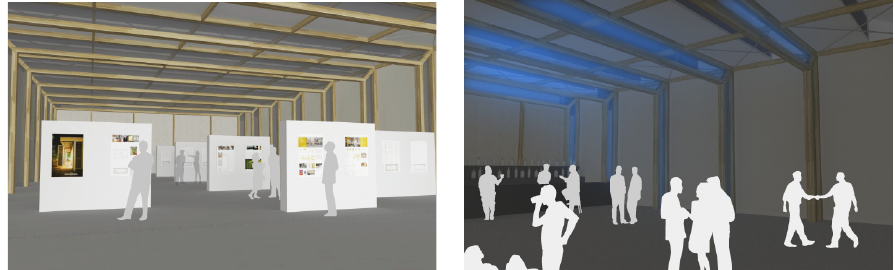
Figure 13a and b: Use of the composite girder as a structural building